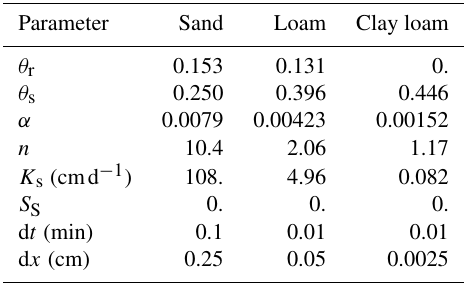
Table 3. Soil hydraulic properties used the Miller et al. (1998) prob-